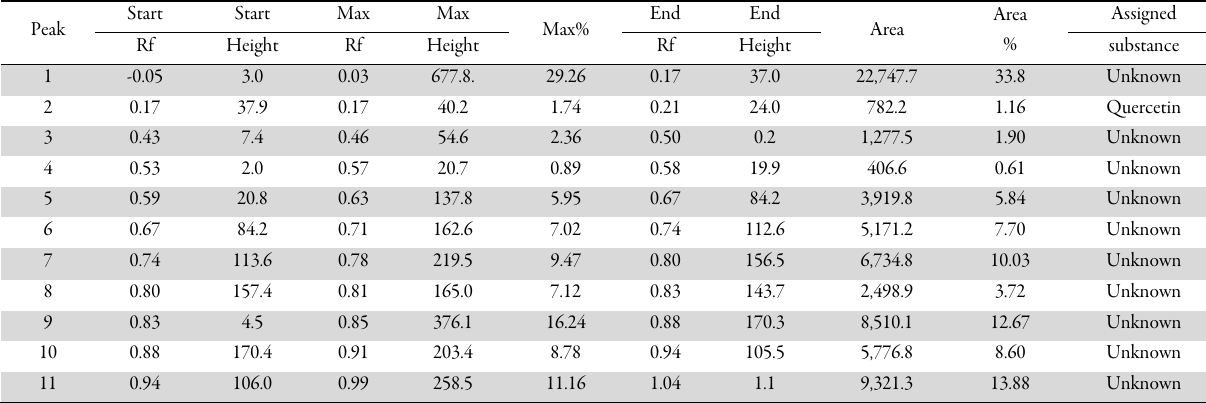
Table 7. HPTLC analysis of soxhalated methanol fruit extract